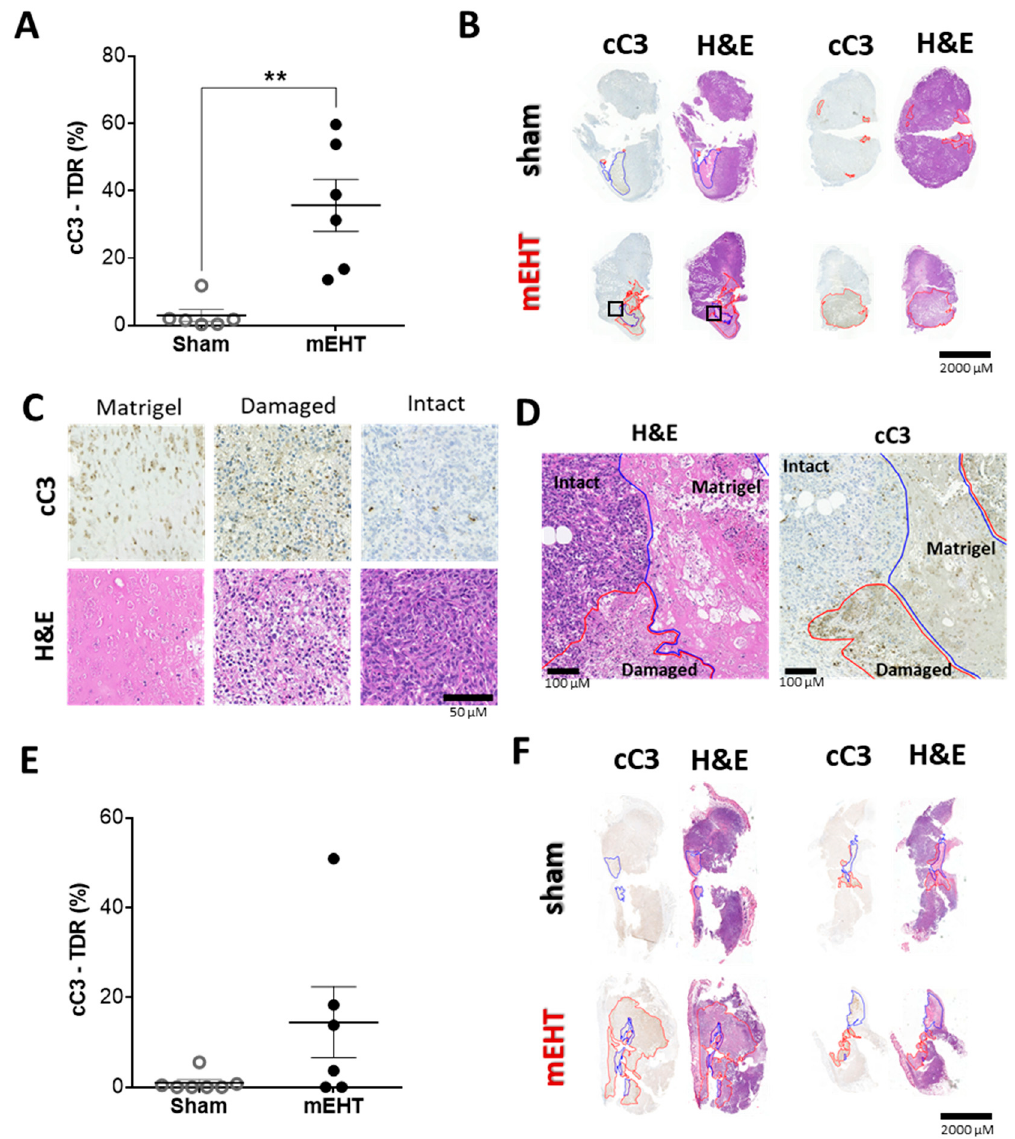
Figure 6. mEHT-induced tumor destruction was cleaved caspase-3 mediated. ( A , B ) Tumor destruction 24 h after two mEHT treatments. ( A ) Tissue destruction ratio (TDR) evaluated in cleaved caspase-3 (cC3) stained sections; ( B ) Apoptotic areas (red contour) and Matrigel ® (blue contour) on representative cC3-stained sections and consecutive H&E stained sections. ( C ) Matrigel ® and damaged tumor areas on cC3 and H&E stained sections (Magnification: 36×); ( D ) Representative images of intact vs. damaged area and Matrigel ® (magnified from H&E and cC3 sections: B/black rectangles, magnification: 8.5×); ( E , F ) Tumor destruction 24 h after one mEHT treatment; ( E ) TDR evaluated on cC3 stainings; ( F ) Apoptotic areas (red contour) and Matrigel (blue contour) on representative cC3-stained sections and consecutive H&E-stained sections. Mean ± SEM, Mann– Whitney test, n = 6/group, ** p = 0.0020